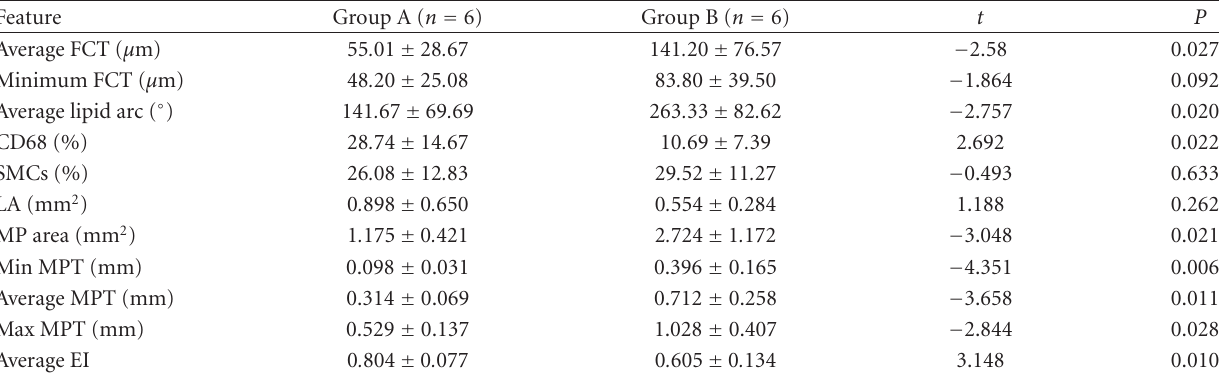
Table 2: Histological findings of plaques from the two experimental